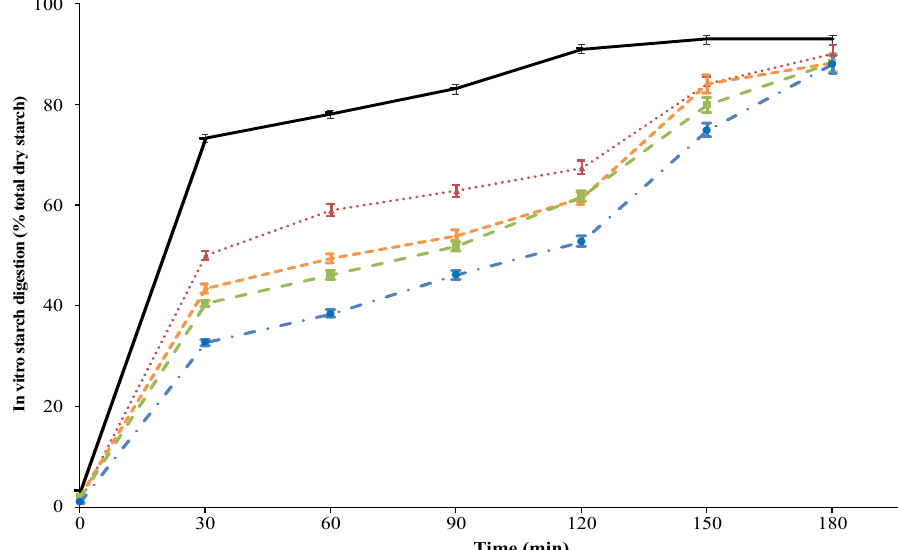
Figure 1. In vitro starch digestion of semolina spaghetti with resistant starch from debranched waxy rice starch (DWRS). Control: spaghetti with 100% w / w durum wheat flour (red line); 5-DWRS: spaghetti with durum wheat flour and DWRS 95:5 w / w (orange line); 10-DWRS: spaghetti with durum wheat flour and DWRS 90:10 w / w (green line); 15-DWRS: spaghetti with durum wheat flour and DWRS 85:15 w / w (blue line). White wheat bread was used as reference (black line).